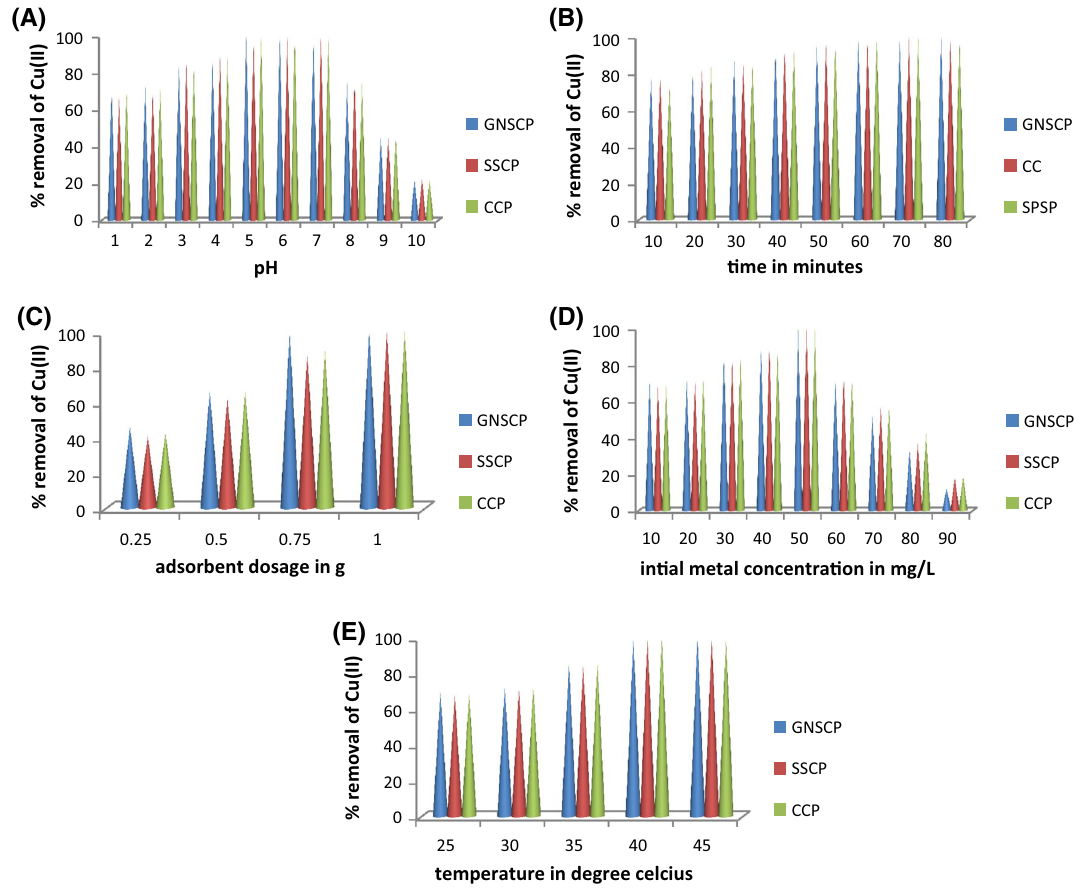
Fig. 3 a Effect of pH b contact time c adsorbent dosage d initial metal concentration e temperature on the removal of Cu(II) using the selected adsorbents Table 1 Adsorption optimization parameters for the removal